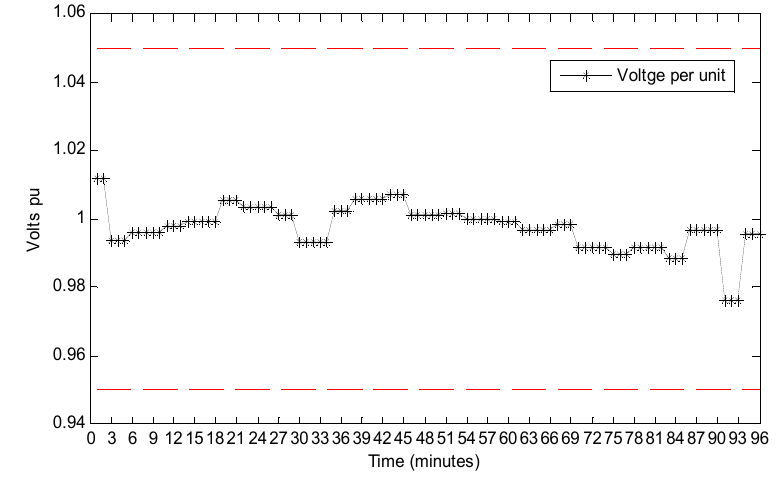
Figure 12. Voltage profile of bus 735 over 15 min time intervals.